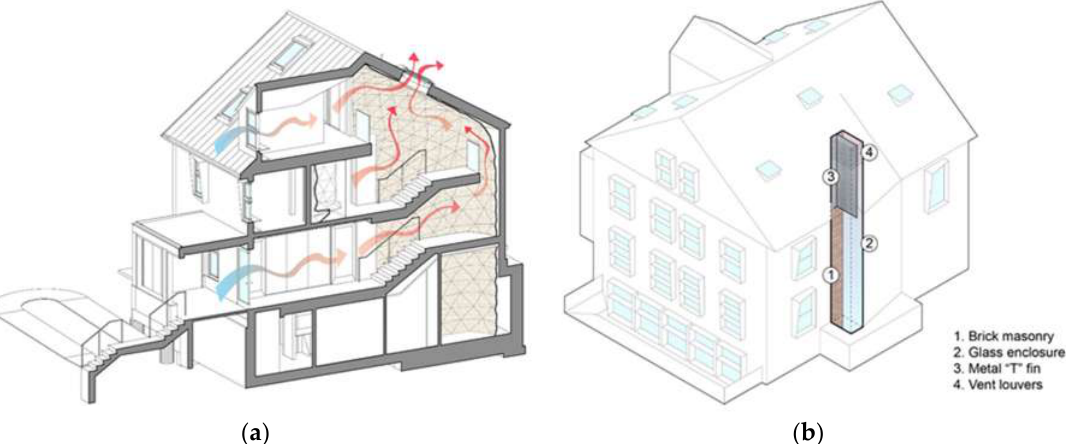
Figure 1. Natural ventilation system for a zero-energy building including windows and skylights: ( a ) Stack ventilation through staircase; ( b ) Solar chimney for buoyancy driven ventilation.